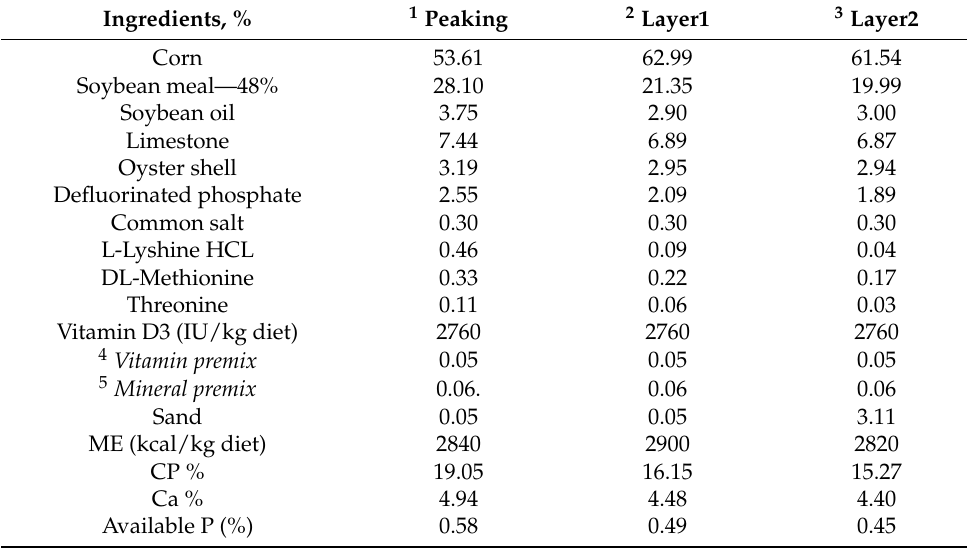
Table 1. Composition of diet from 18 to 52 weeks of age. Ingredients,